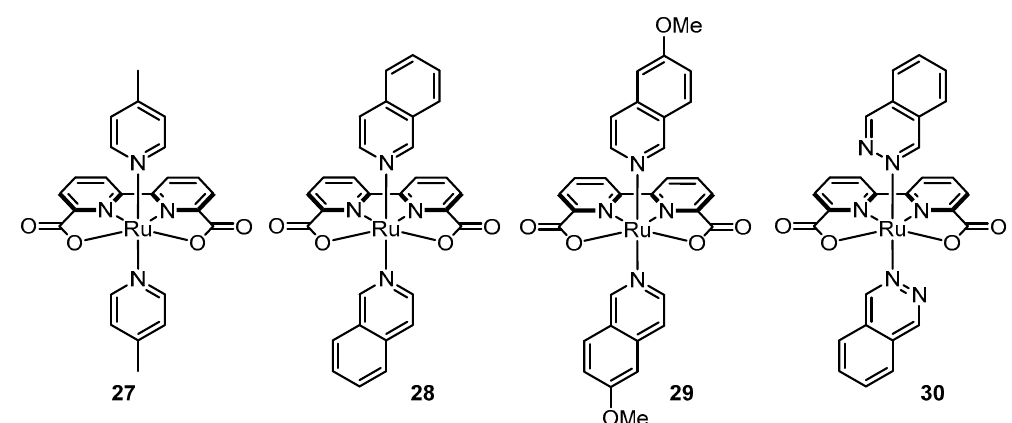
Molecules 2019 , 24 , x Figure 13. Prominent examples of Ru(bda) complexes with varying heterocycles in the axial positions.